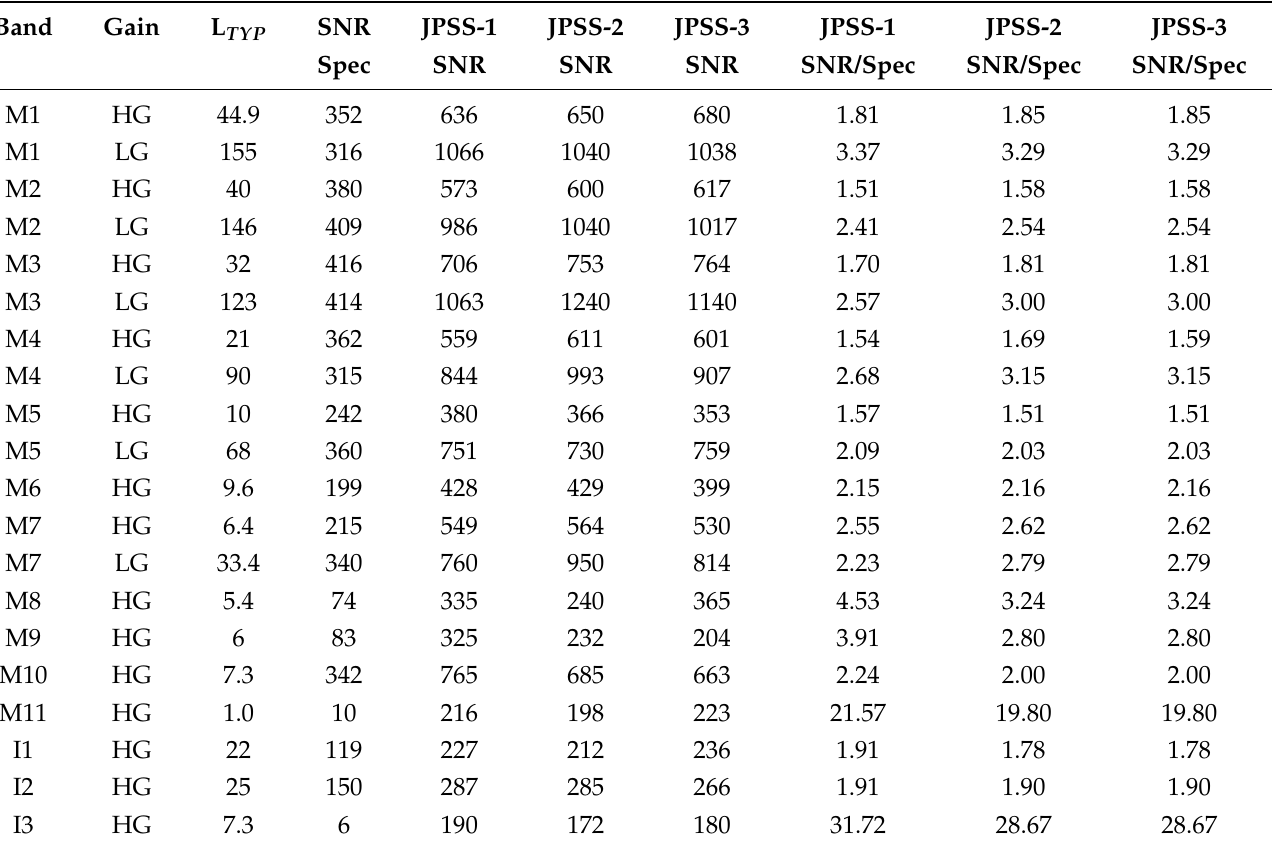
Table 4. JPSS-3 VIIRS RSB SNR at L TYP relative to the sensor specification [10]. JPSS-1 and JPSS-2 results are included for